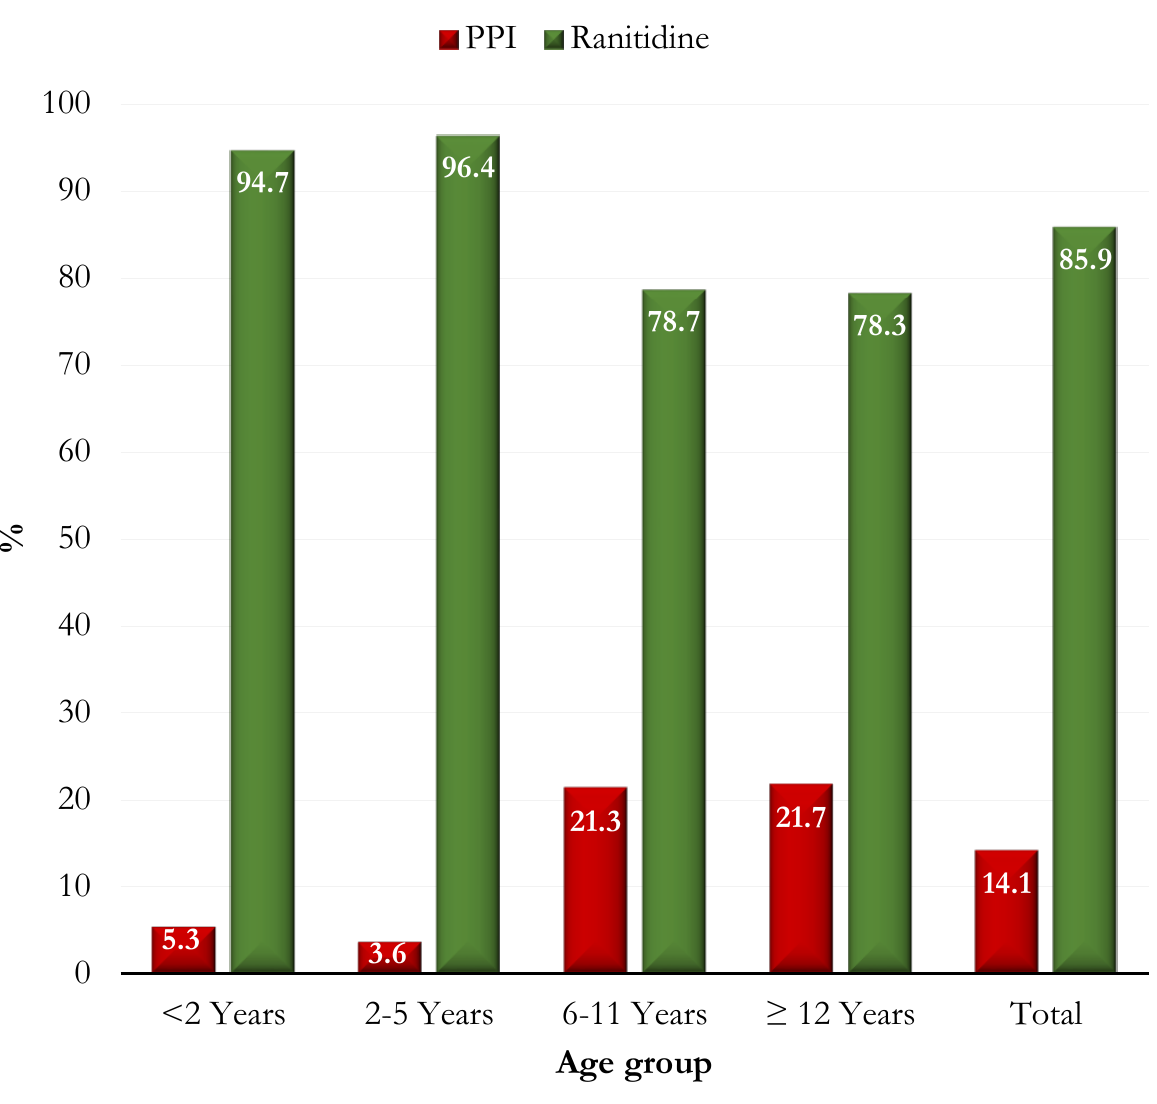
Figure 4. Percentage of patients on ranitidine or PPI therapy, stratified by age group.